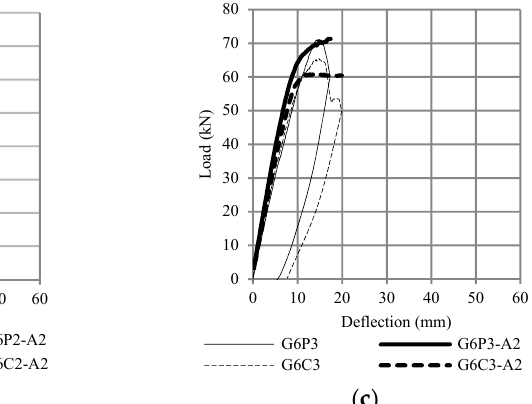
Figure 12. Comparison between test results and the finite element method (ATENA 2D) ( a ) reinforcement ratio 1%, ( b ) reinforcement ratio 1.5%, and ( c ) reinforcement ratio 2.5%.